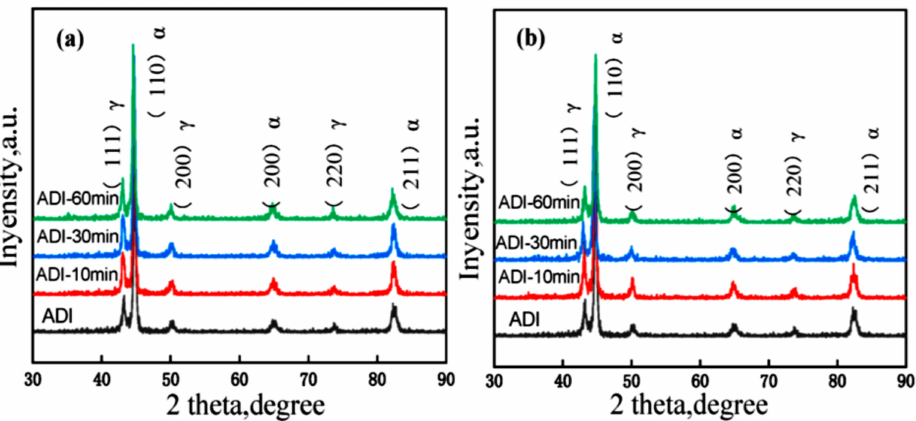
Figure 19. Crystallographic structure of austempered ductile iron specimens partitioned at ( a ) 200 ◦ C and ( b ) 300 ◦ C